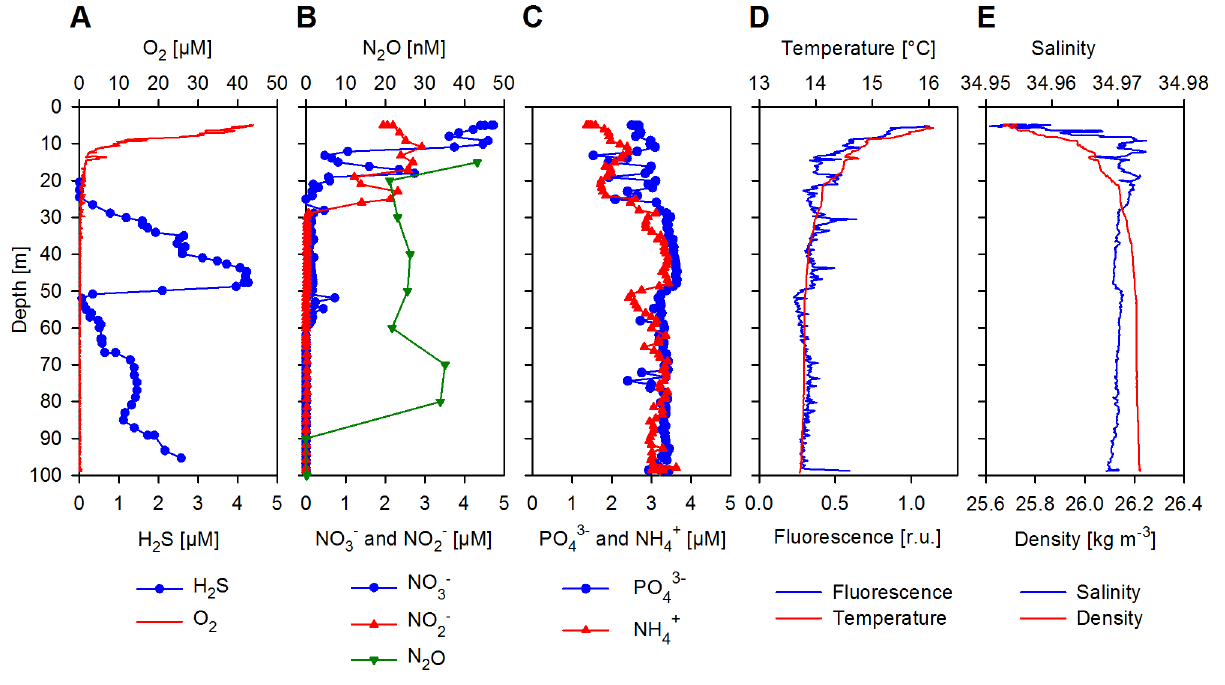
Figure 2. Vertical distribution of physical, chemical and biological water properties. (A) Concentrations of H 2 S and O 2 . (B) Concentrations of NO 3 2 , NO 2 2 and N 2 O. (C) Concentrations of PO 43 2 and NH 4 + . (D) In situ fluorescence (chlorophyll, relative units as measured with the pump-CTD) and temperature. (E) Salinity and